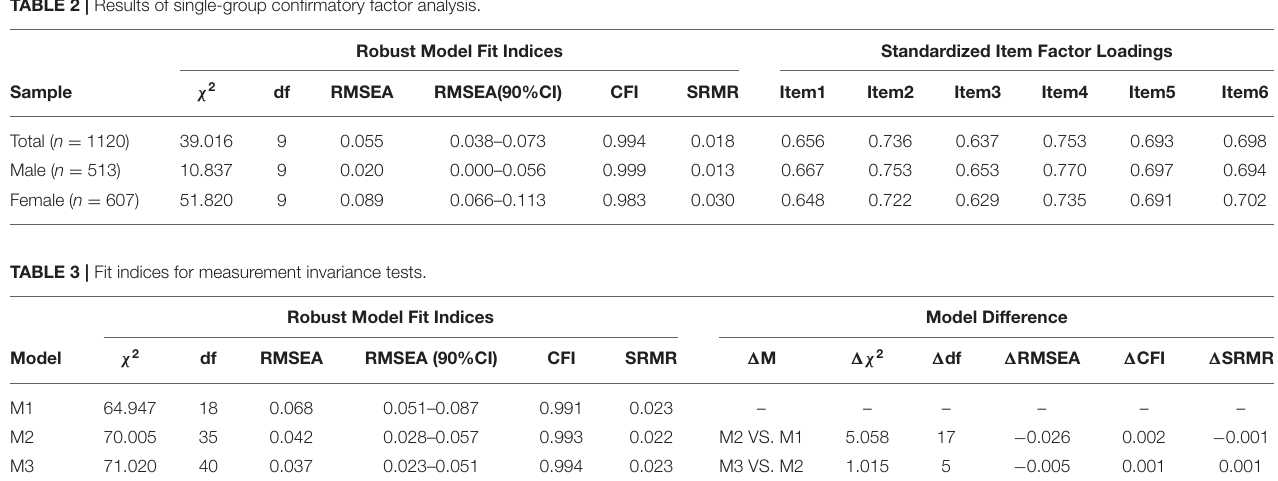
TABLE 2 | Results of single-group confirmatory factor analysis.